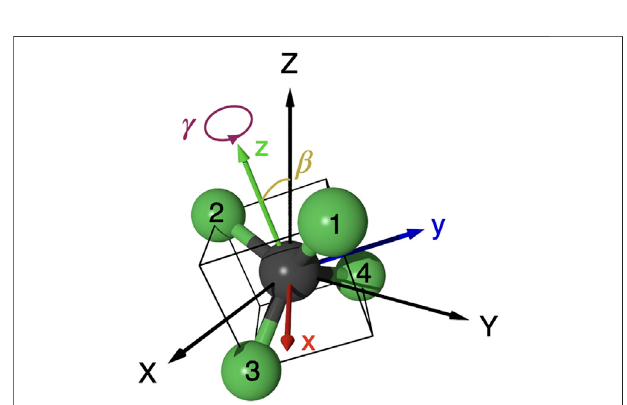
FIGURE 2 | Molecular orientation of CF 4 in the laboratory frame ( X , Y , Z ),wherethepolarizationdirectionofthelinearlypolarized ω — 2 ω laser fi elds is directed along the Z -axis. The molecular principal axis ( C 2 axis) is along the z -axis of the molecular frame( x , y , z ). Theorientation is speci fi ed by the Euler angles ( α , β , γ ). Because of the axial symmetry around the electric fi eld F one can set α =0 without losing